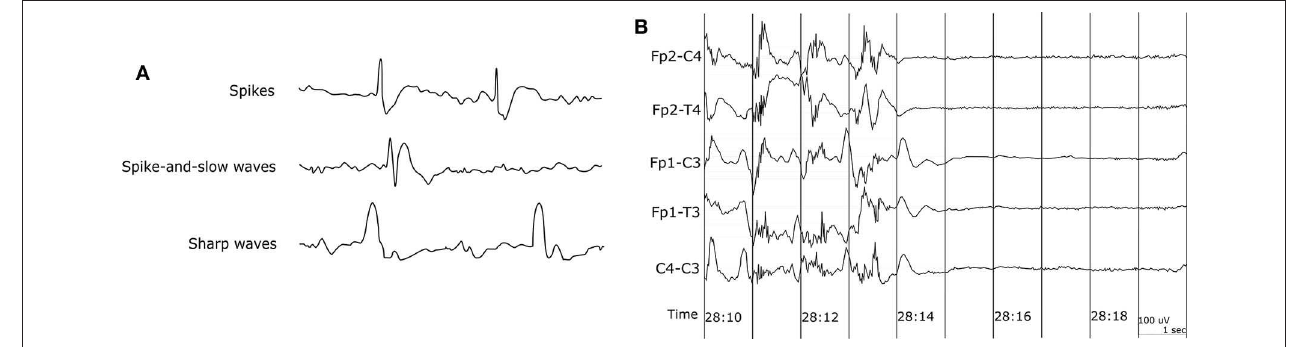
FIGURE 2 | EEG waveform. (A) EEG waveform with paroxysmal abnormality. (B) Sudden death in epilepsy recorded in ambulatory EEG